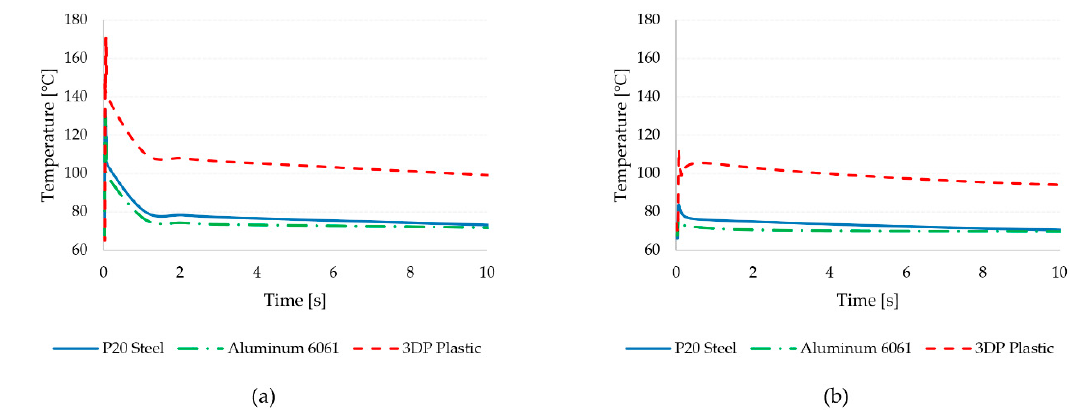
Figure 14. Part ( a ) and mold ( b ) temperature probed close to the microfeatures of Group C for the different mold insert materials (cf. Table 7).